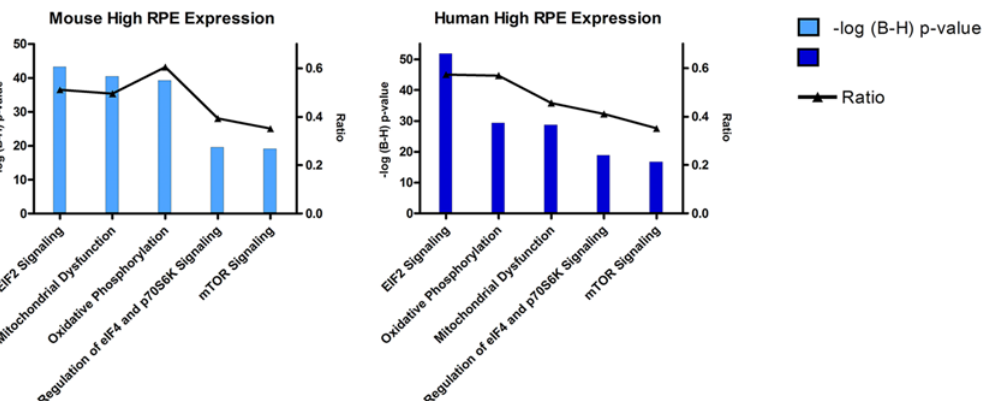
Fig 4. Most significant canonical pathways identified by Ingenuity for the “ Mouse High RPE gene expression ” and “ Human High RPE expression gene expression ” datasets. The left y-axis displays the – log of Benjamini-Hochberg corrected p-value. The right y-axis displays the ratio of the number of genes derived from our dataset, divided by the total number of genes in the pathway. The blue line indicates the threshold of the BH corrected p-value of